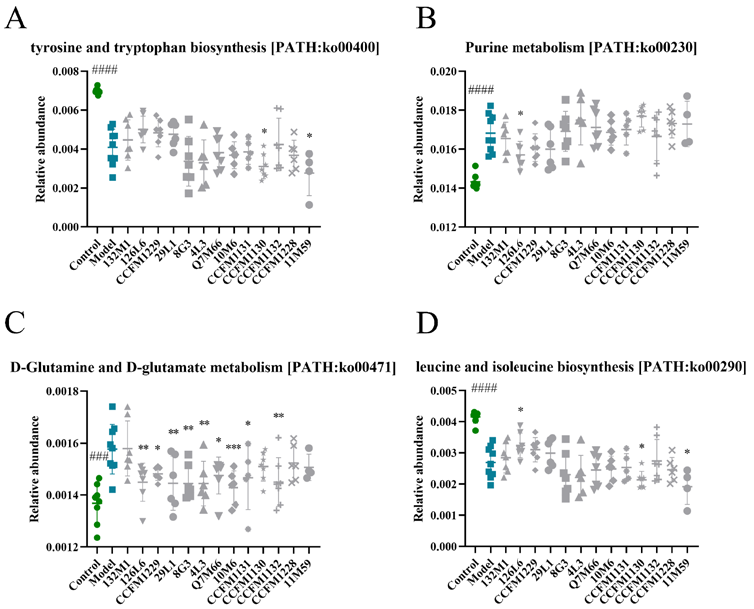
Figure 6. KEGG function prediction of 16S rRNA by PICRUSt2. ( A ) Tyrosine and tryptophan biosynthesis. ( B ) Purine metabolism. ( C ) D-glutamine and D-glutamate metabolism. ( D ) Leucine and isoleucine biosynthesis. ### p < 0.001; #### p < 0.0001; * p < 0.05; ** p < 0.01; *** p < 0.001; comparing with depression group.